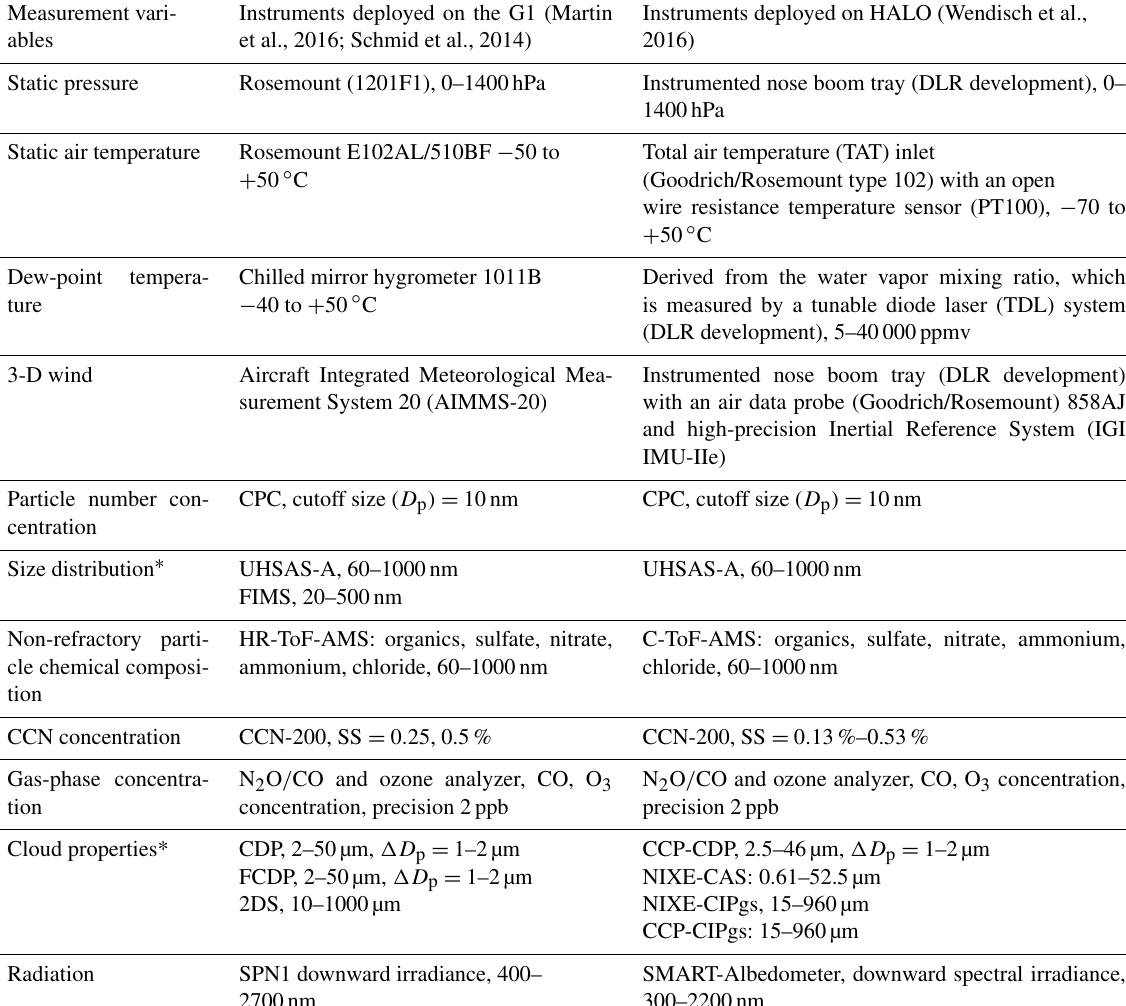
Table 1. List of compared measurements and corresponding instruments deployed aboard the G1 and HALO during GoAmazon2014/5. The acronyms are defined in a table at the end of this paper. D p indicates the particle diameter. (cid:49)D p refers to the size